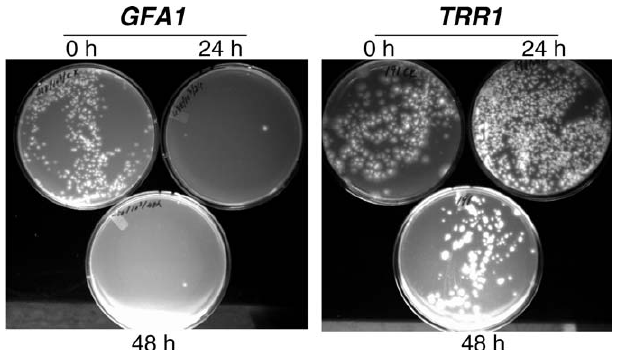
Figure 5. Determination of Cidal or Static Terminal Phenotypes A representative example of cidal and static terminal phenotypes for GFA1 and TRR1 p NiiA -CPR mutants is shown. (A) p NiiA -GFA1 displayed a cidal terminal phenotype as a dramatic (greater than 90%) reduction in CFU was observed after incubation in p NiiA -repressing conditions for 24 or 48 h. (B) p NiiA - TRR1 revealed a static terminal phenotype as no significant